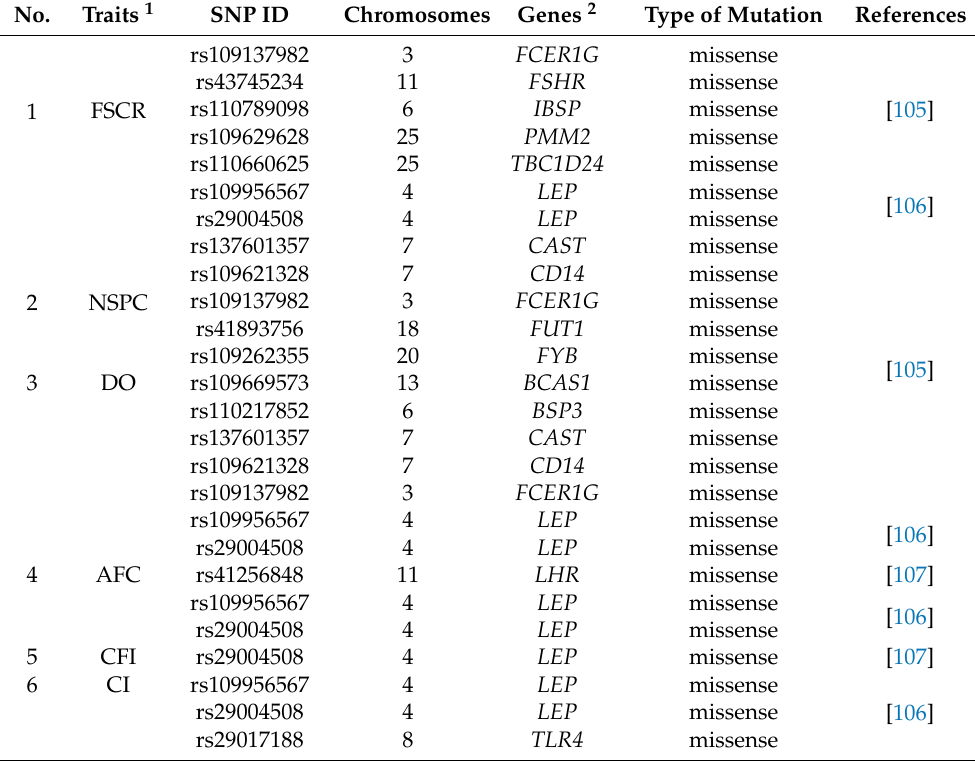
Table 3. Candidate genes that were previously associated with fertility traits in cattle. No. Traits 1 SNP ID Chromosomes Genes 2 Type of